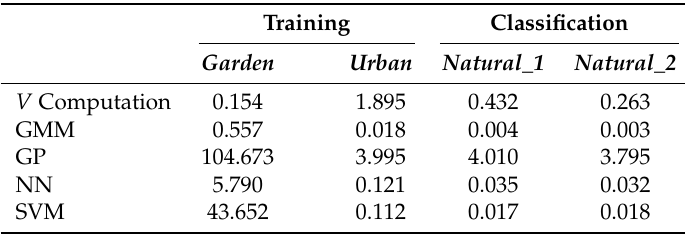
Table 5. Computation times for training and classification, in seconds.